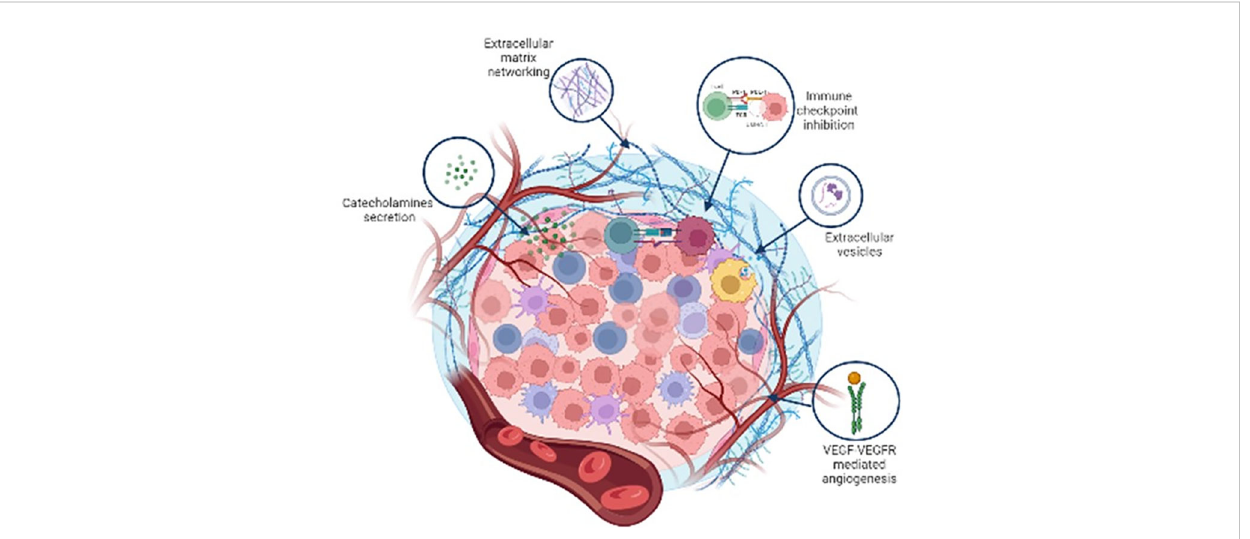
FIGURE 3 Schematic representation of the major non cellular components of Pheo/PGL tumour